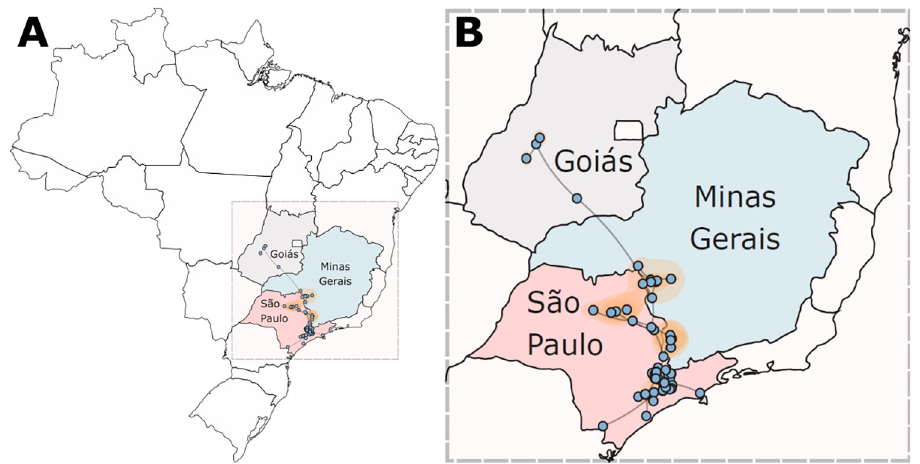
Fig 5. Highest posterior probability migration paths for the YFV Clade II from 2015 to 2019 towards and beyond the MRSP, based on the analysis of 91 complete genomes (dataset 2). ( A ) Migration on the full map of Brazil, and ( B ) migration being viewed up close. The spatiotemporal spread was visualized with spreaD3 v.0.9.7.1, using a GeoJSON file, (MIT license https://www.kaggle.com/datasets/moiseslima/majson?resource=download) to visualize the spatial YFV